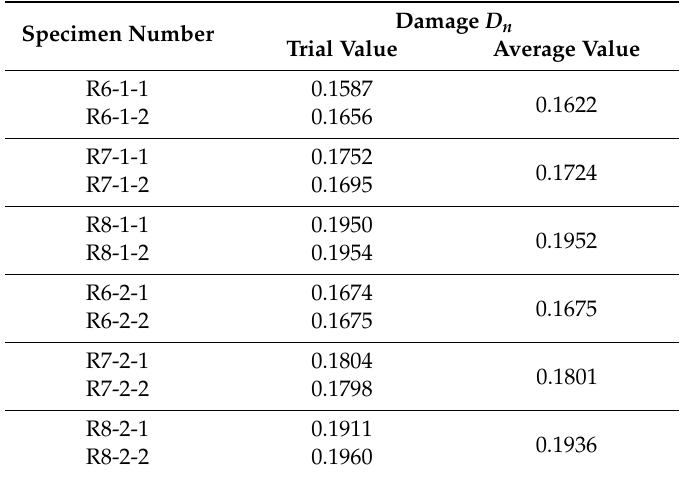
Table 5. Rock specimen damage variable D n in the cyclic loading and unloading